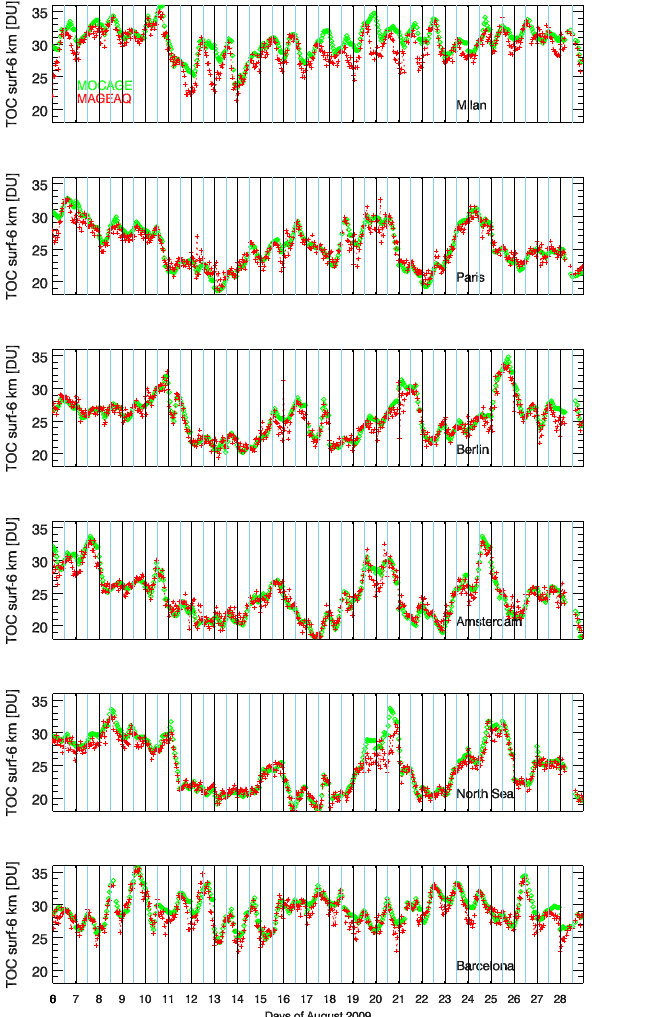
Fig. 7. Same as Fig. 6 but for surface (cid:0) 3 km TOC. Time series of MOCAGE surface (cid:0) 6 km TOC pseudo-reality (green), and MAGEAQ-TIR sur- face (cid:0) 6 km TOC pseudo-observations (red) over Milan, Paris, Berlin, Amsterdam, the marine location West of Norway coast, Barcelona.